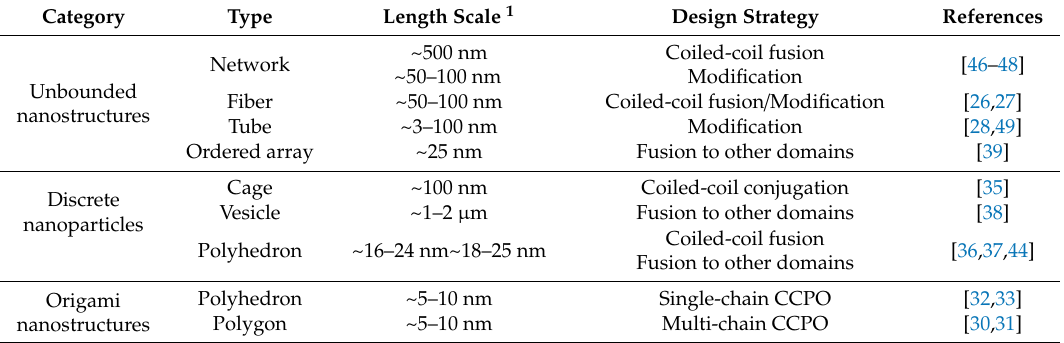
Table 1. Representative protein nanostructures assembled from coiled-coil-based building